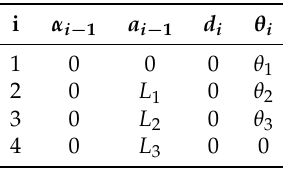
Figure 2. Definition of the axis and frame with respect to base when undercarriage of the excavator is fixed to the ground. Table 2. Denavit–Hartenberg table of Figure